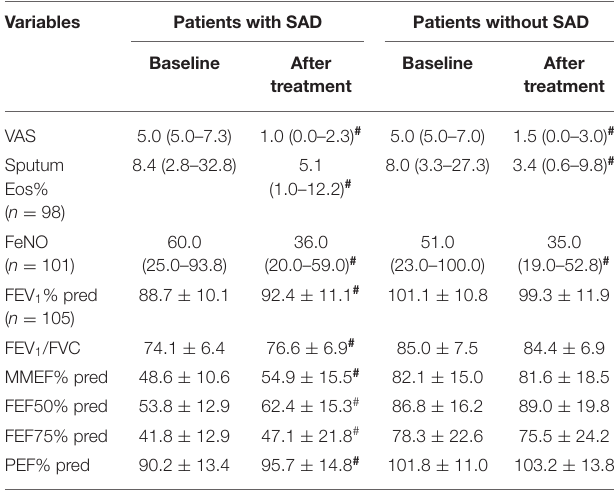
TABLE 3 | Clinical and pathophysiological parameters in patients with SAD and patients without SAD at baseline and after antiasthmatic treatment for 2